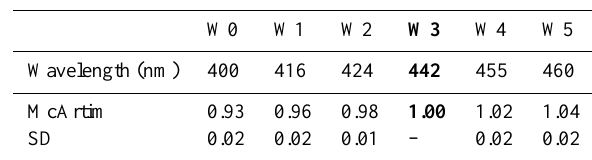
Table 4. Corrections of the effective light path according to radia- tive transfer modelling for the MAX-DOAS measurements. The ref- erence measurements, W3, are in